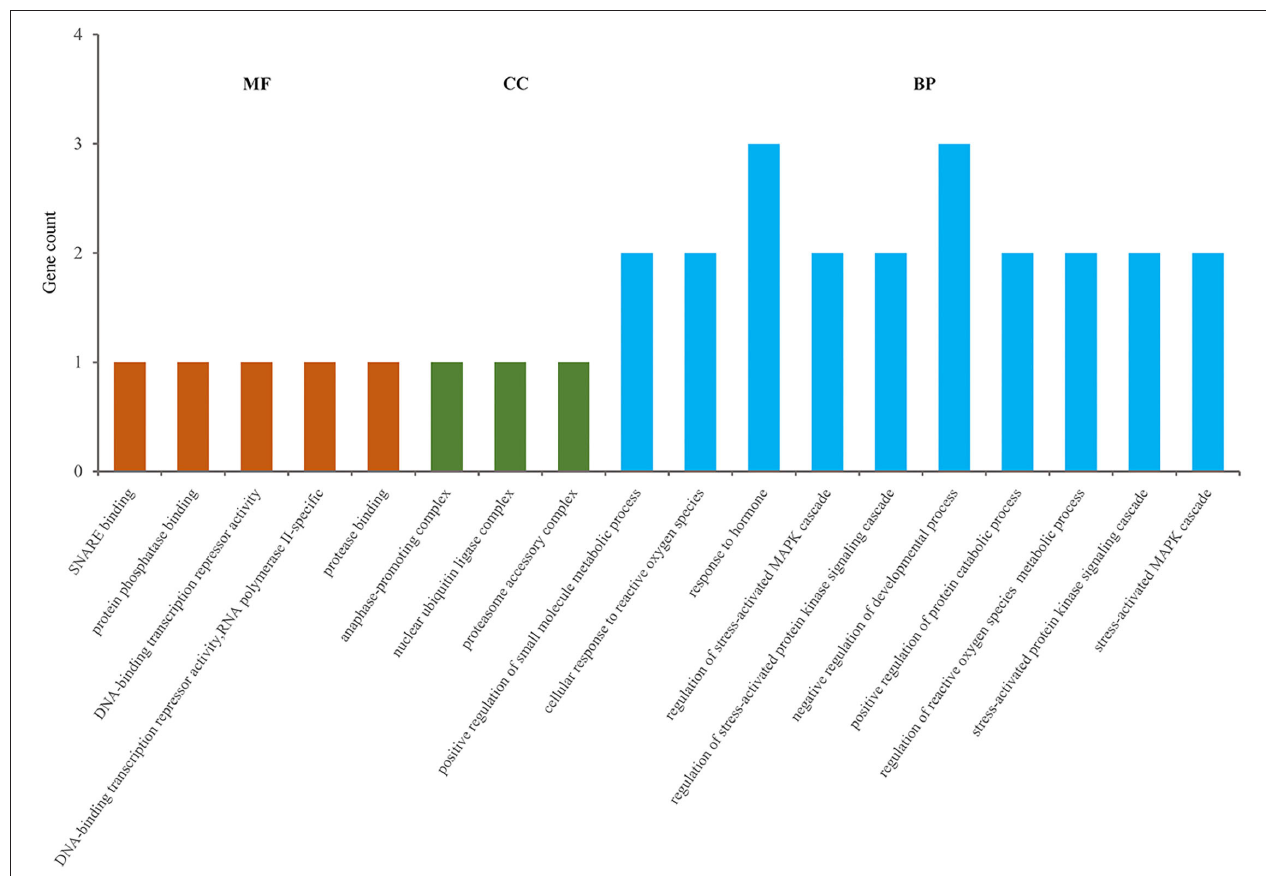
FIGURE 6 | GO annotation of DEGs, and the significance level of enrichment was set at P < 0.05